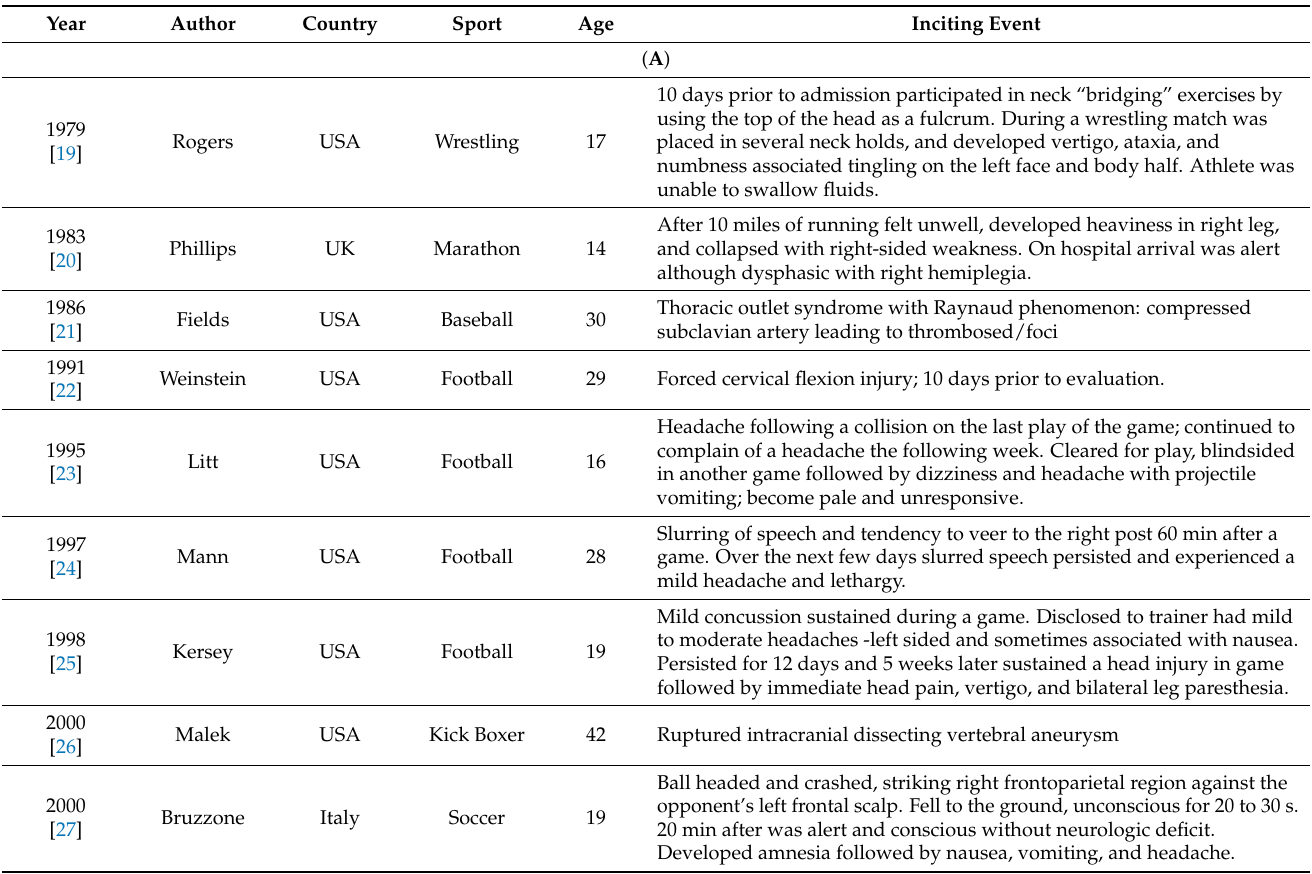
Table 1. ( A ) Case Reports (80.5%, 29/36) by year, author, country, sport, age (years), and inciting event. ( B ) Articles (19.4%, 7/36) by year, author, country, sport, age (year), and inciting